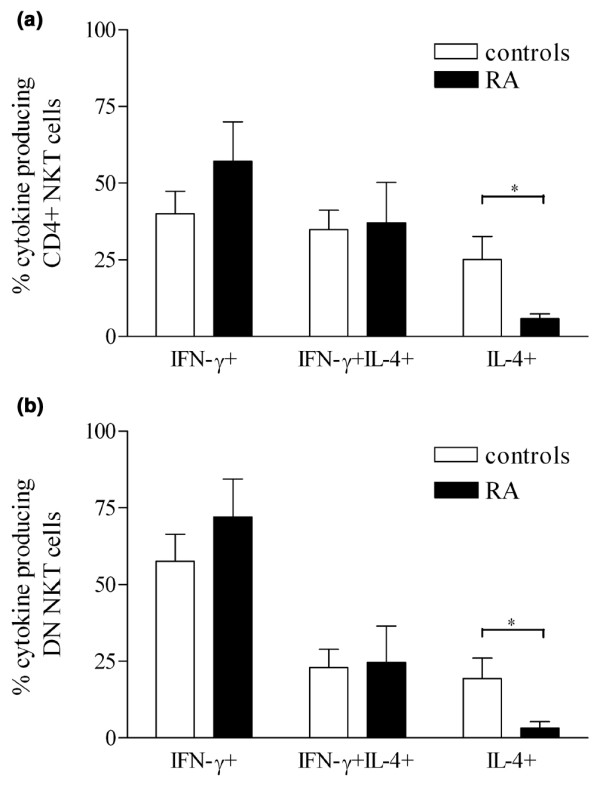
Cytokine profile of CD4+ and CD4- natural killer T (NKT) cell lines derived from peripheral blood mononuclear cells from rheumatoid arthritis (RA) patients and healthy control individuals. Vα24+ cells of α-galactosylceramide (α-GalCer) stimulated, 14-day-old cultures from nine healthy control individuals and nine RA patients were isolated using biomagnetic selection. The cytokine profile of (a) CD4+ and (b) CD4- NKT cells was assessed by intracellular staining. Error bars indicate standard error of the mean. *P < 0.05.